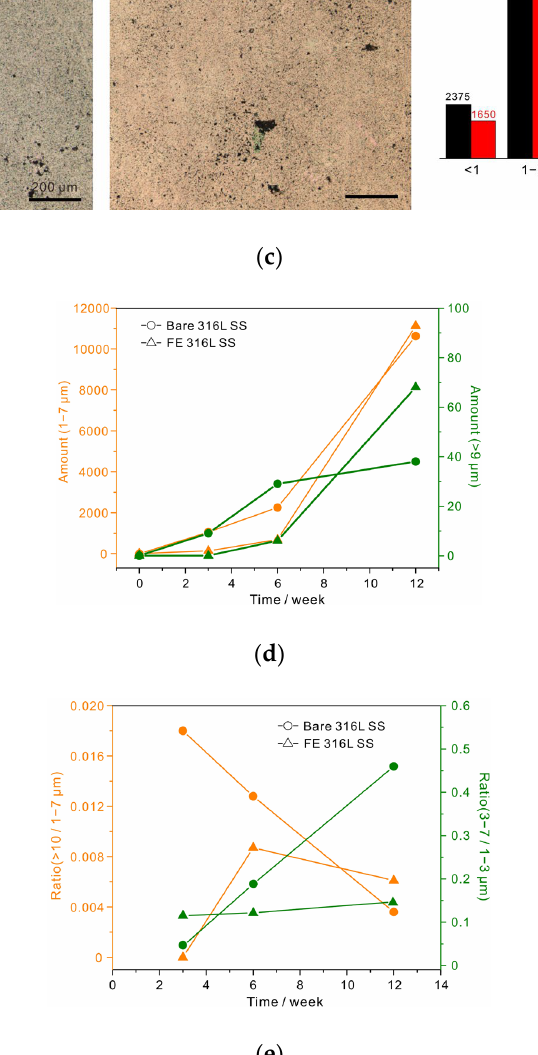
Figure 3. Optical microscopy photographs of 316 L SS (left) and FE 316 L SS (right) after immersion for ( a ) 3 weeks, ( b ) 6 weeks, and ( c ) 12 weeks, and the corresponding statistical results. ( d ) The development of metastable pits and stable pits, respectively. ( e ) The metastable-to-stable pit transformation ratio and the transformation ratio of metastable pits with small sizes (1–3 µm) to metastable pits with larger sizes (3–7 µm).